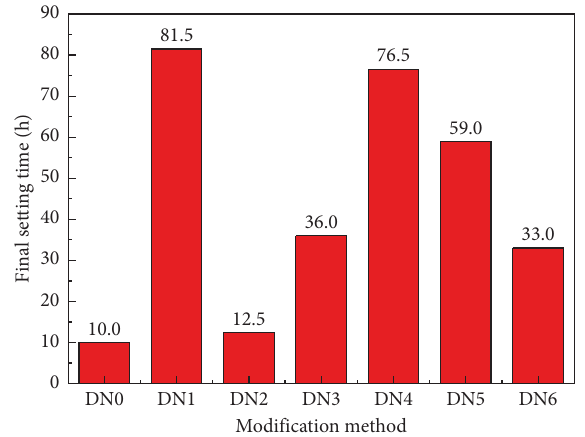
Figure 3: Final setting time of SFCC